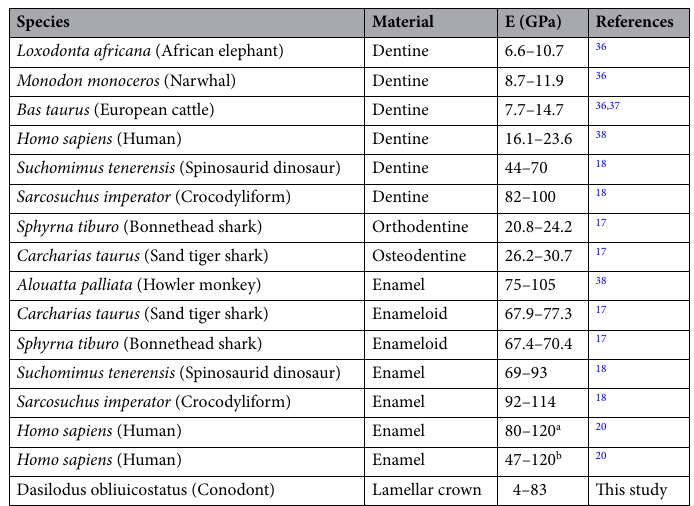
Table 1. Young’s modulus (E) of vertebrate dentition. Comparison of Young’ modulus (E) of vertebrate dentition from the literature with the results of this study. The orientation of the measured transects in the cited literature varies from across the functional surface in some studies a to variation with depth from the functional surface to the dentine-enamel junction (DEJ) b , to “mid-point” values between the functional surface and